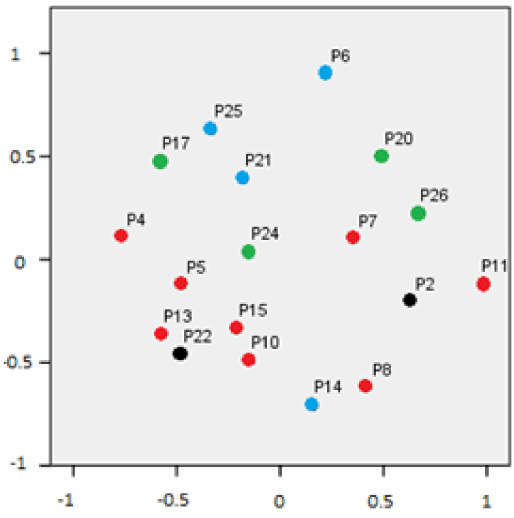
Figure 2. Two-dimension distribution of